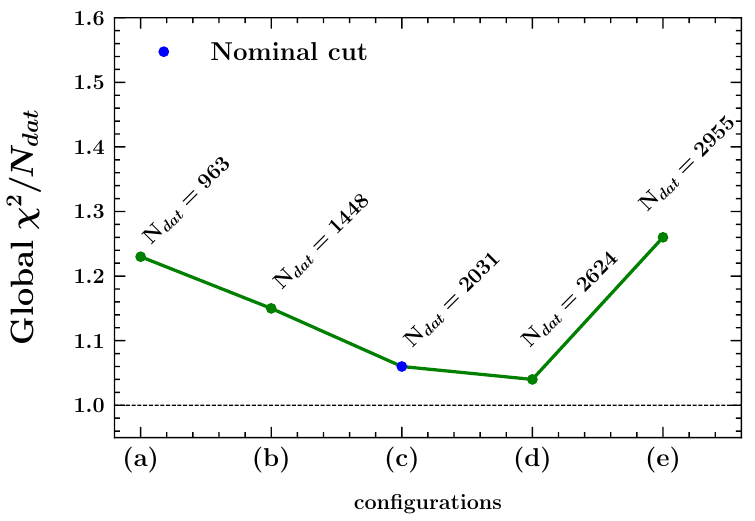
Figure 17 . Global χ 2 /N dat for different configurations of the kinematic cut on SIDIS data sets (see text). The blue point corresponds to the reference cut used in the present baseline